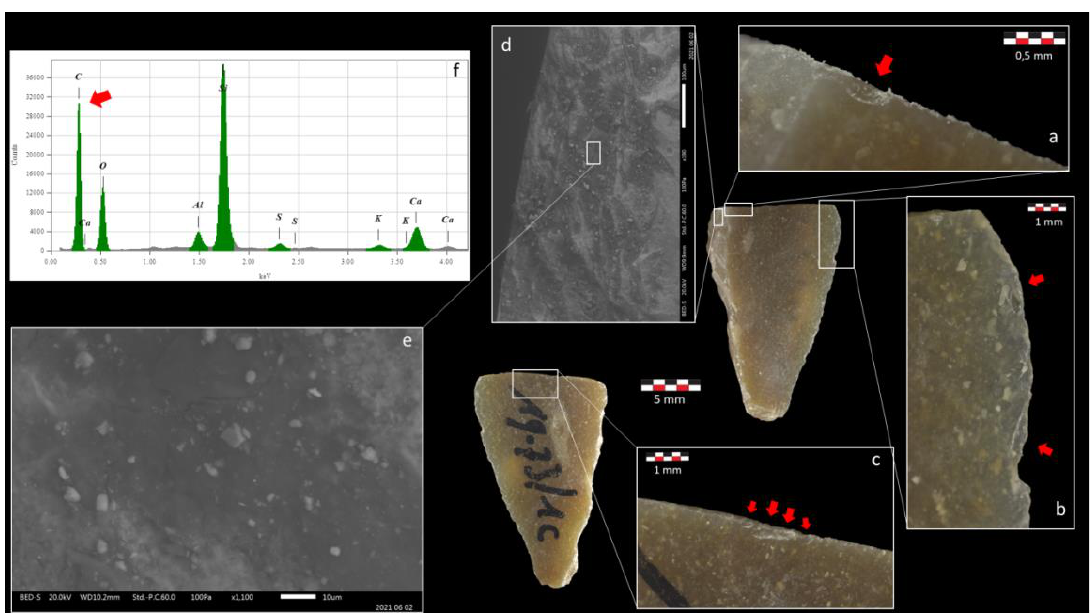
Figure 14 . Macroscopic details of the impact damage present on the curved backed piece LB57A.1973-1c which permitted it to identify it as a possible projectile fragment, but the combination of traces was insufficient to be fully certain. The piece presents a combination of : a)+b) bending breaks, secondary damage and; b) oblique oriented lateral scars in opposite directions (b). Possible hafting glue observed on the back: (d) backscattered electron image showing its presence on the backed edge of the tool (e) detail of the amorphous organic residue, showing no distinctive features (f) elemental analysis of the residue, indicating the highly organic composition of the residue as illustrated by the abundant presence of carbon (indicated with red arrow).